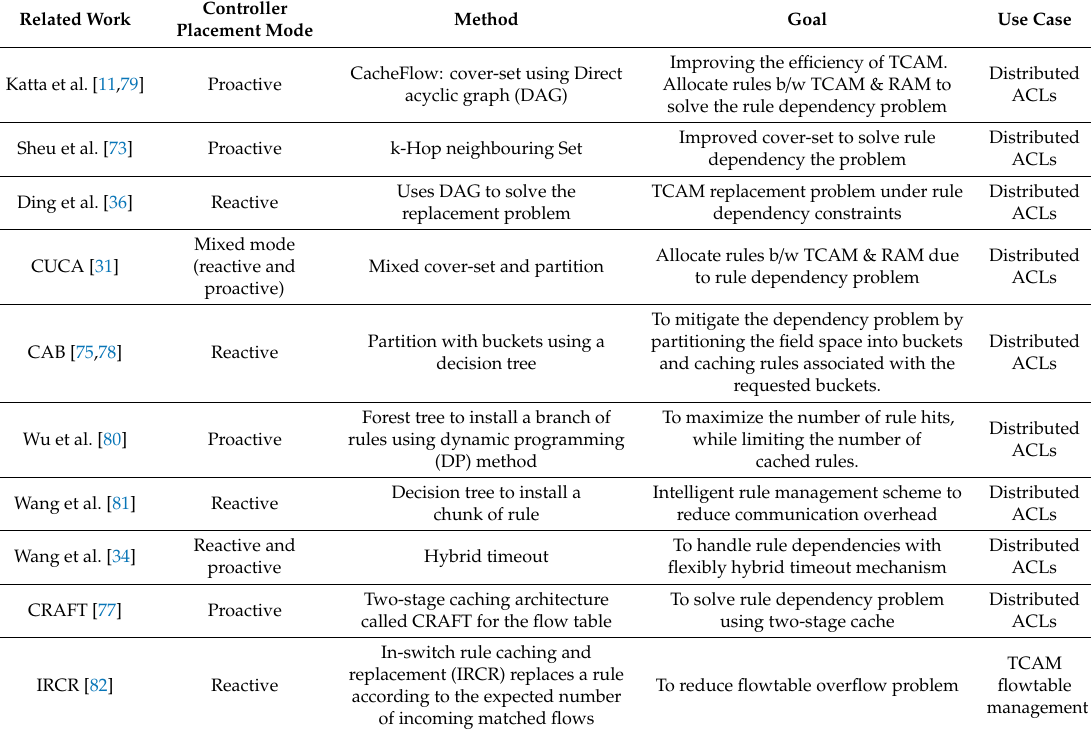
Table 4. Comparison of the related works of rule caching mechanism to improve flow table